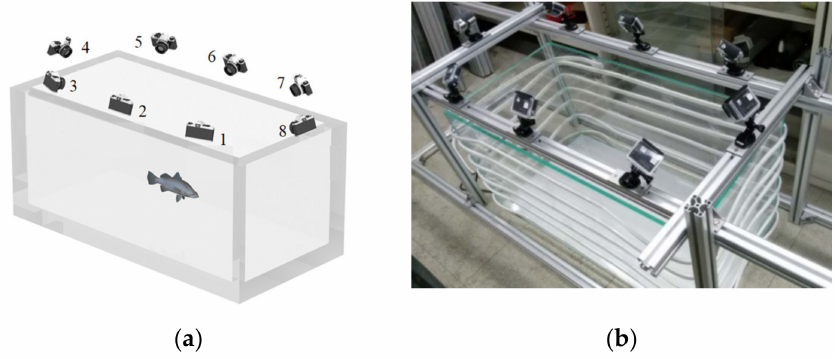
Figure 10. Experimental platform. ( a ) The test bench layout diagram, ( b ) The picture of the real test